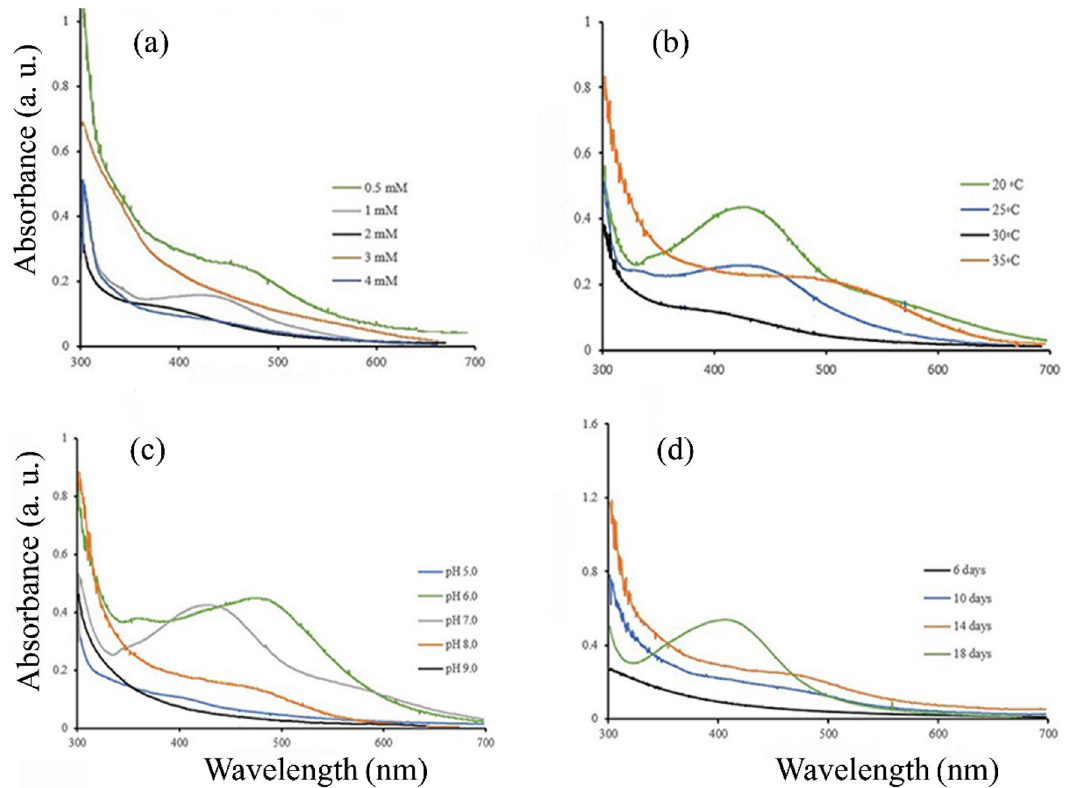
Figure 2. Optimization process of the nanoparticle by measuring UV–visible absorption spectra of biosynthesized AgNPs at different ( a ) AgNO 3 concentrations, ( b ) temperatures, ( c ) pH, and ( d ) incubation